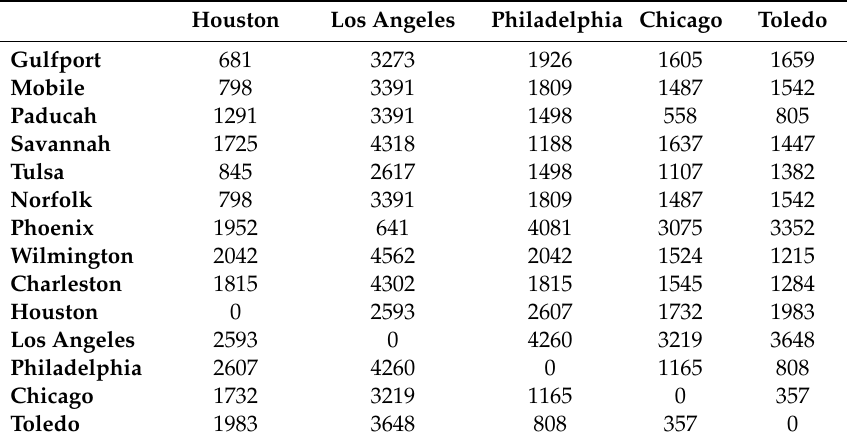
Table A8. Rail distances between Transesterification and Demand locations